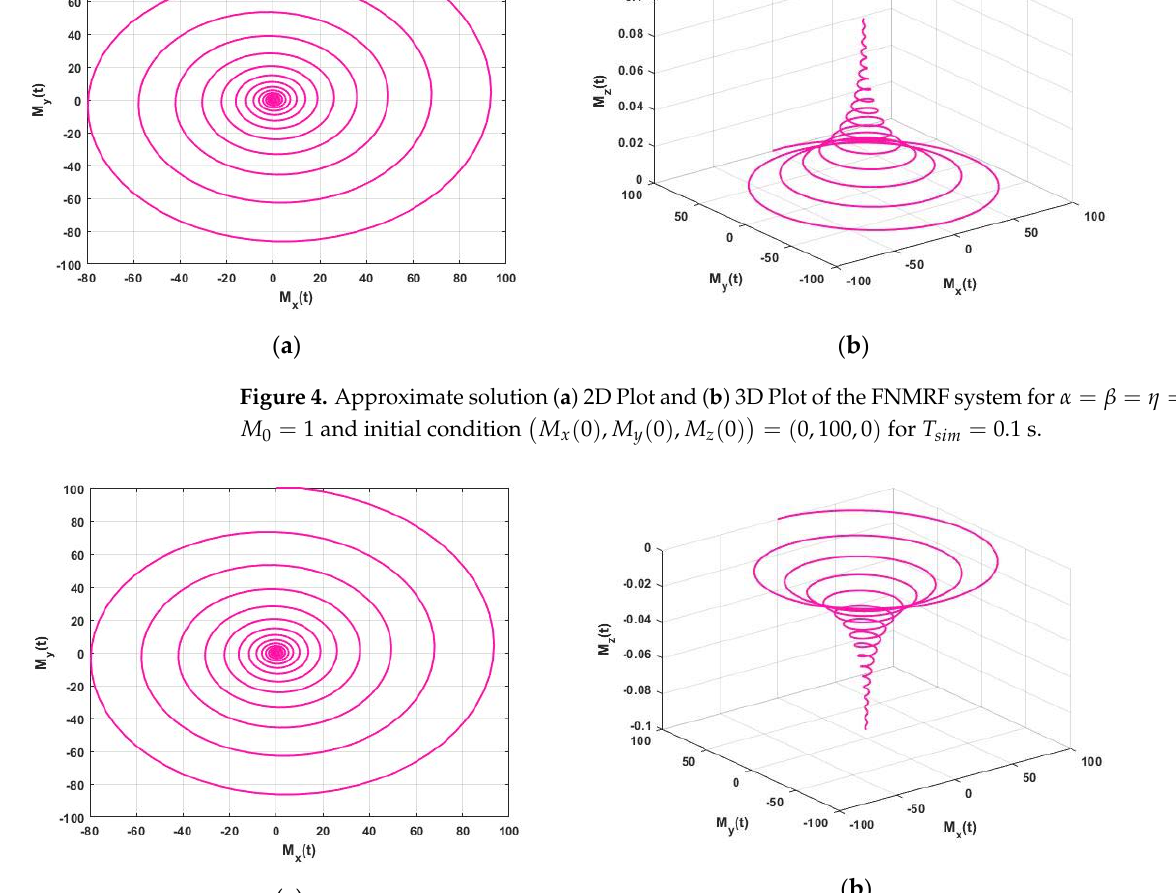
( b ) Figure 6. Approximate solution ( a ) 2D Plot and ( b ) 3D Plot of the FNMRF system for 𝛼 (cid:3404) 𝛽 (cid:3404) 𝜂 (cid:3404) 0.9 and initial condition (cid:4672)𝑀 (cid:3051) (cid:4666)0(cid:4667), 𝑀 (cid:3052) (cid:4666)0(cid:4667),𝑀 (cid:3053) (cid:4666)0(cid:4667)(cid:4673) (cid:3404) (cid:4666)0,100,0(cid:4667) for 𝑇 (cid:3046)(cid:3036)(cid:3040) (cid:3404) 0.2 s . Figure 8 represents the comparison between the approximate solution and the ana ‐ lytical solution of the fractional FNMRF system for 𝑀 (cid:3051) (cid:4666)𝑡(cid:4667), 𝑀 (cid:3052) (cid:4666)𝑡(cid:4667) and 𝑀 (cid:3053) (cid:4666)𝑡(cid:4667) , respective ‐ ly [23,24], for height steps ℎ (cid:3404) 0.01 and ℎ (cid:3404) 0.001 . We can see an excellent consistency of the solution and a similar result may also be detected for 𝑀 (cid:3053) (cid:4666)𝑡(cid:4667) ; see Table 1. From these observations, we conclude that the approxi ‐ mate solution well matches the analytical solution. The condition of stability for equa ‐ tion orders 𝛼 (cid:3404) 0.8, 𝛽 (cid:3404) 1, 𝜂 (cid:3404) 0.9 of the solution is described in Figure 7. Figures 1–7, in 2D and 3D, illustrate the dynamics between 𝑀 (cid:3051) (cid:4666)𝑡(cid:4667) , 𝑀 (cid:3052) (cid:4666)𝑡(cid:4667) , and 𝑀 (cid:3053) (cid:4666)𝑡(cid:4667) . For both cases, magnetization of the entire trajectory is presented in 3D with the starting point (cid:4672)𝑀 (cid:3051) (cid:4666)0(cid:4667), 𝑀 (cid:3052) (cid:4666)0(cid:4667), 𝑀 (cid:3053) (cid:4666)0(cid:4667)(cid:4673) (cid:3404) (cid:4666)0,100,0(cid:4667) and the return to its equilibrium value of 𝑀 (cid:2868) .